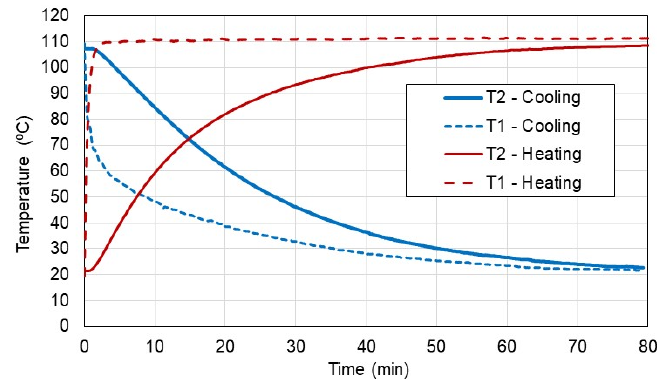
Figure 4. Inner T2 and outer T1 temperatures for heating and cooling tests.